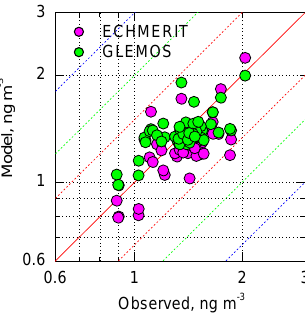
1 Figure 6. Scatter-plots of annual mean GEM air concentration in 2013 measured at ground-based sites (Annex A, 2 Figure 6. Scatter plots of annual mean GEM air concentration in Table A.1) vs. simulated by GLEMOS and ECHMERIT. Red solid line depicts the 1:1 ratio; dashed lines show 3 different deviation levels: red – by factor of 1.5, green – by factor of 2, blue – by factor of 3. 4 2013 measured at ground-based sites vs. simulated by GLEMOS and ECHMERIT. Red solid line depicts the 1:1 ratio, while dashed lines show different deviation levels: red by a factor of 1.5, green by a factor of 2, and blue by a factor of 3.